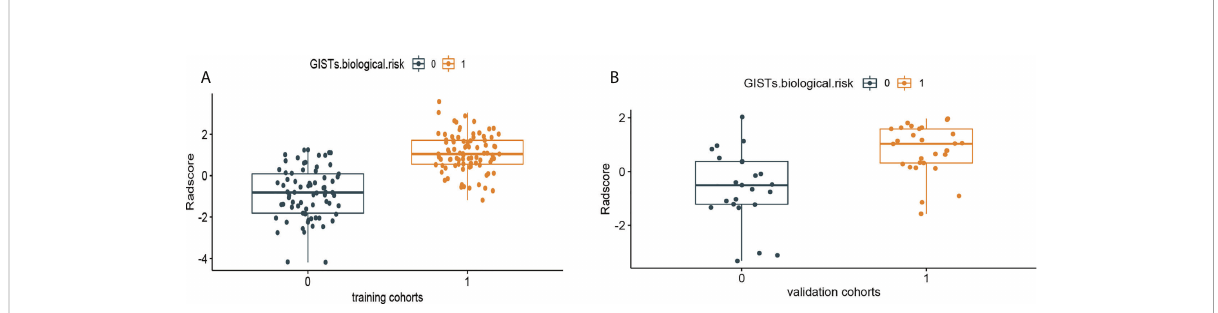
FIGURE 6 Rad-Score distribution of the 216 patients for (A) the training cohort and (B) validation cohort. The low-malignant potential group is colored blue (0), and the high-risk group is colored yellow